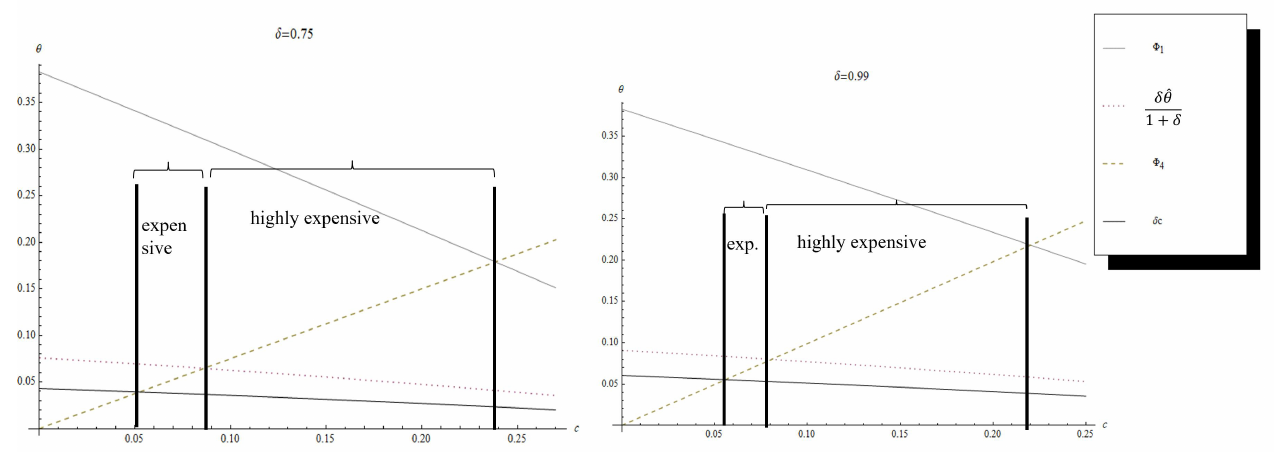
Figure 7. Existence of of expensive and highly expensive equilibria: δ = 0.75 and δ =